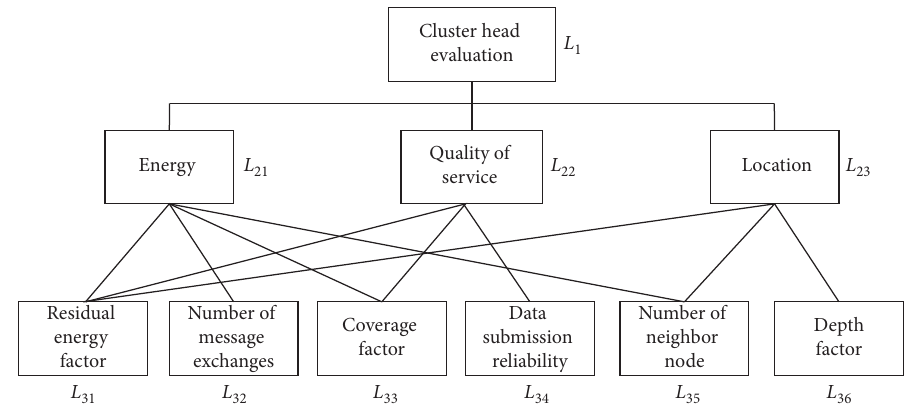
Figure 3: Comprehensive evaluation hierarchical structure of the cluster